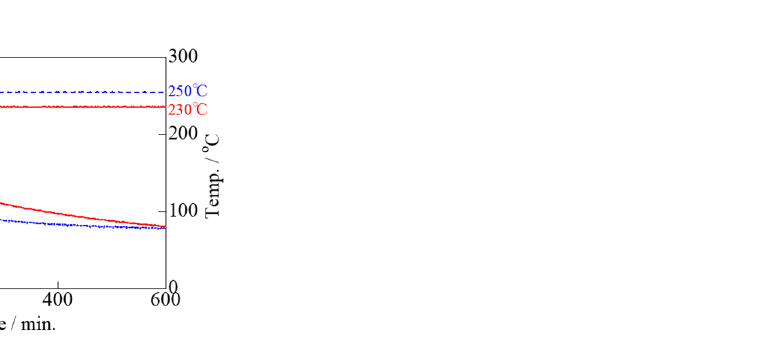
Figure 15. Isothermal TG analysis of carbon black (2 wt%) mixed with the Tl 2 O 3 ‒ 95 wt% Bi 2 O 3 composite catalyst at constant temperatures of 230 and 250 °C for 10